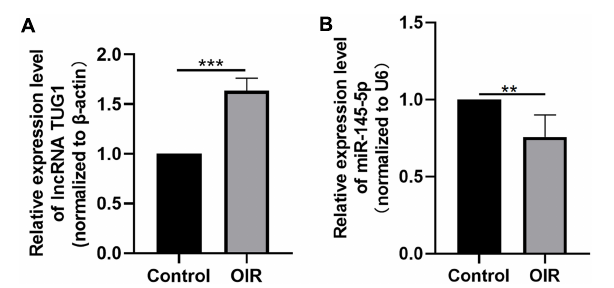
FIGURE 1 | Tug1 expression was upregulated and miR-145-5p was down-regulated in OIR mice. (A) Tug1 expression level (mean ± SD, n = 5). *** P < 0.001. (B) MiR-145-5p expression level (mean ± SD, n = 5). ** P <